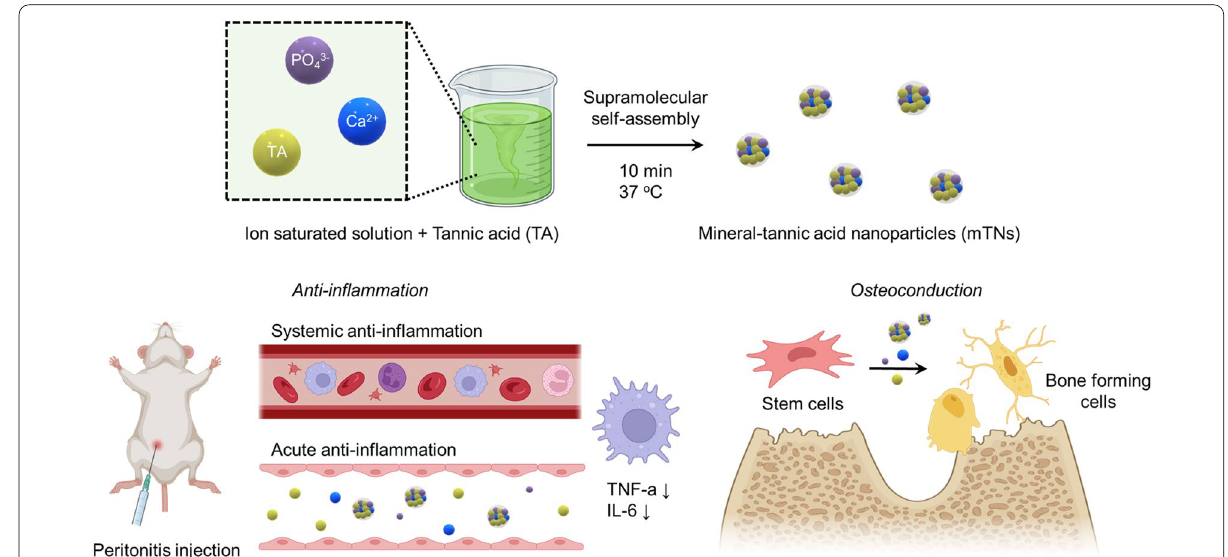
Scheme 1 Schematic illustration of mTN fabrication and multi‑functionality of